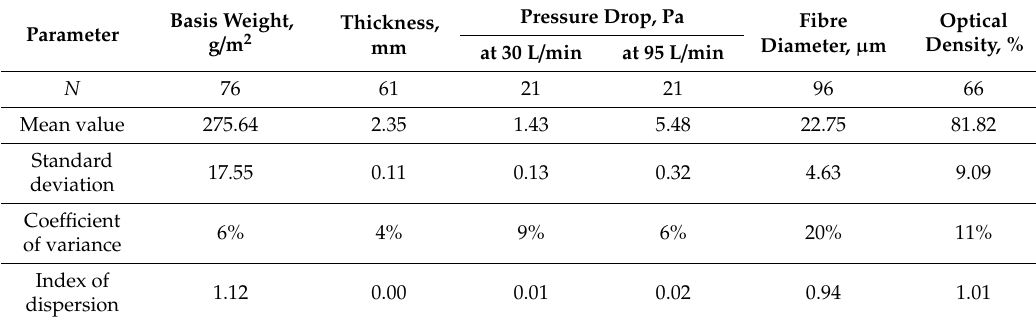
Table 2. Morphological parameters of AC-NW composite.